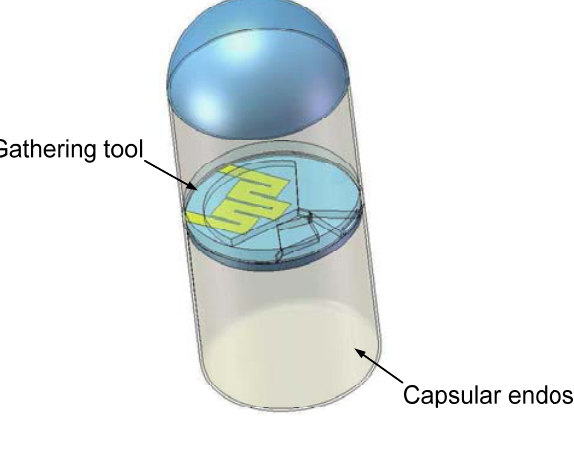
Figure 1. The conceptual schematic of a versatile capsular endoscope integrated with a gathering tool (In order to present clear concept, other components except for the gathering tool are